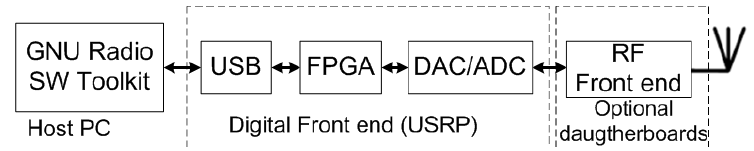
Figure 7. Architecture of GNU software